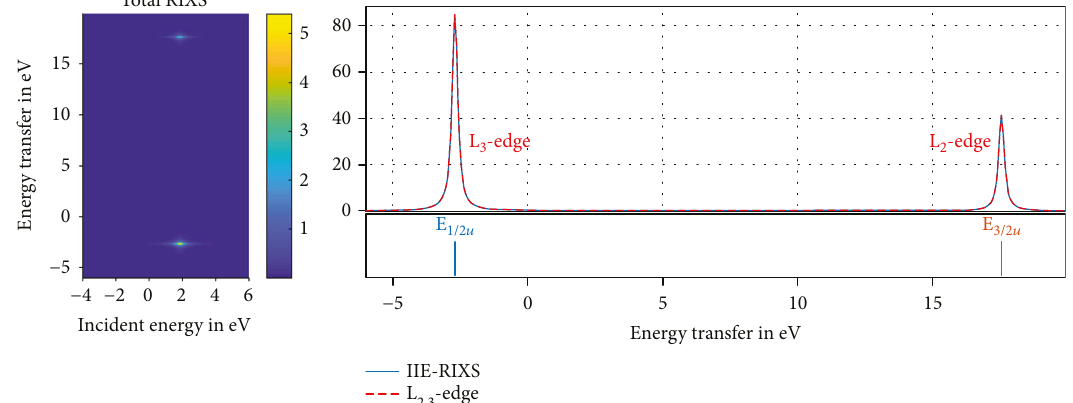
Figure 7: Calculated 1s2p RIXS map for 10D q =3.0eV with 2p XES projection for Cu 2+ (3d 9 ) for 10D q =3.0eV. The 2p XES appears identical to the 2p XAS. The mixing induced by the crystal fi eld symmetry breakdown enables to populate the J = 1/2 and J = 3/2 fi nal states in direct 2p